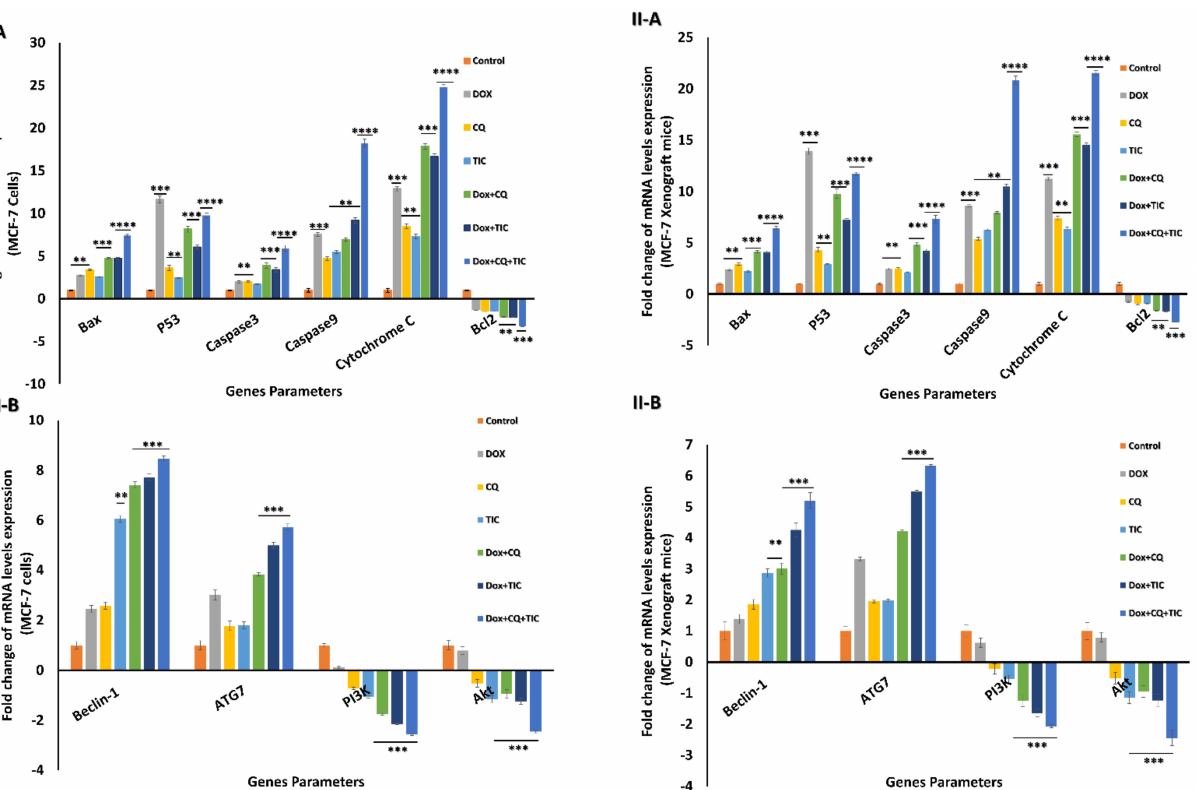
Figure 6. The fold change alternations in mRNA levels. Bar diagram showing mRNA levels fold change of MCF-7 cells ( I ) and MCF-7 Xenograft mice ( II ) treated with single or combinatorial treatments relative to control. Bax, p53, caspase-3, caspase-9, Cytochrome C, and Bcl2 as apoptotic and anti-apoptotic genes ( A ), Beclin-1, ATG7, PI3K, and AKT as autophagic and growth proliferative signaling genes ( B ). Values are expressed as mean ± SE, n = 3. Data are presented as mean ± SE (error bar) of at least three independent experiments. * p < 0.05, ** p < 0.01, *** p < 0.001, **** p < 0.0001 compared with control (untreated -cells or -mice)